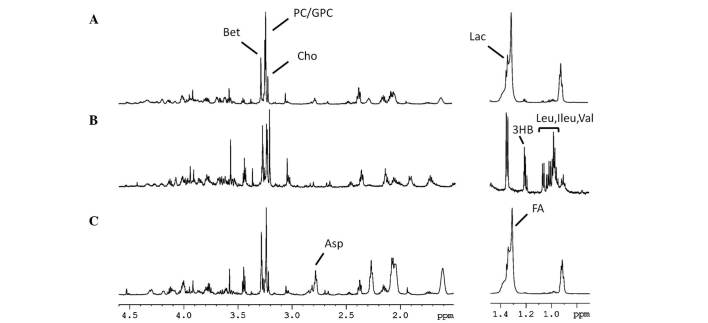
Representative 1H MAS NMR spectra of the pancreatic tissues in the (A) control, (B) severe chronic pancreatitis and (C) mild chronic pancreatitis groups. The region of δ1.50–4.60 ppm is zoomed in 4 times of that in δ0.50–1.50 ppm (600 MHz, CPMG pulse sequence, temperature 300.0 K). Bet, betaine; PC/GPC, phosphocholine/glycerophosphocholine; Cho, choline; Lac, lactate; 3HB, 3-hydroxybutyrate; Leu, Ileu, val, leucine/isoleucine/valine; Asp, aspartate; FA, fatty acids; MAS, magic-angle spinning; NMR, nuclear magnetic resonance; CPMG, Carr-Purcell-Meiboom-Gill.